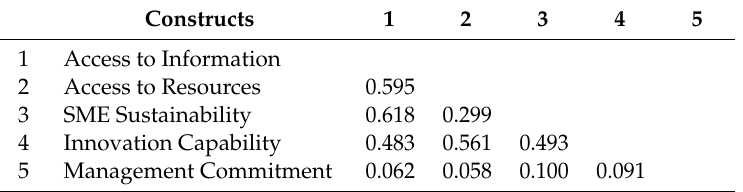
Table 3. Discriminant validity assessment using Heterotrait-Monotrait